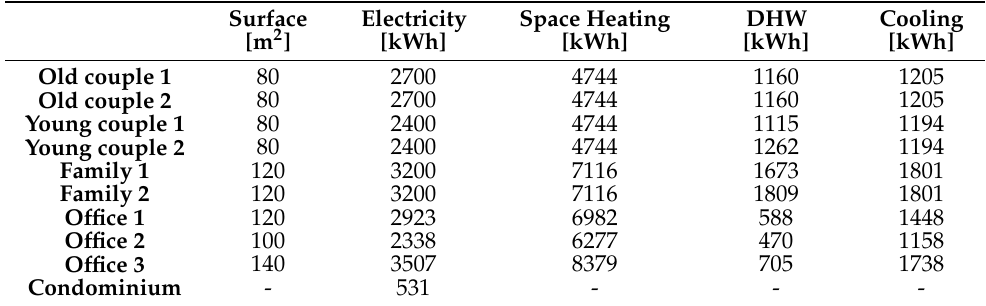
Table 2. Floor area and total yearly electricity, space heating, domestic hot water (DHW), and cooling demands for each